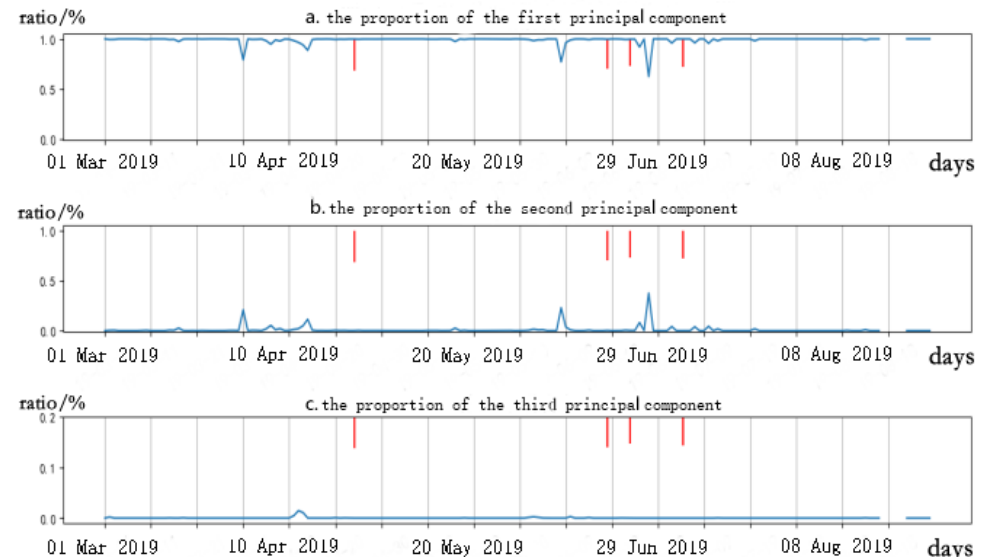
Figure 5. Multi-PCA features; red line means earthquake. The stations used in this figure, WCFZ,